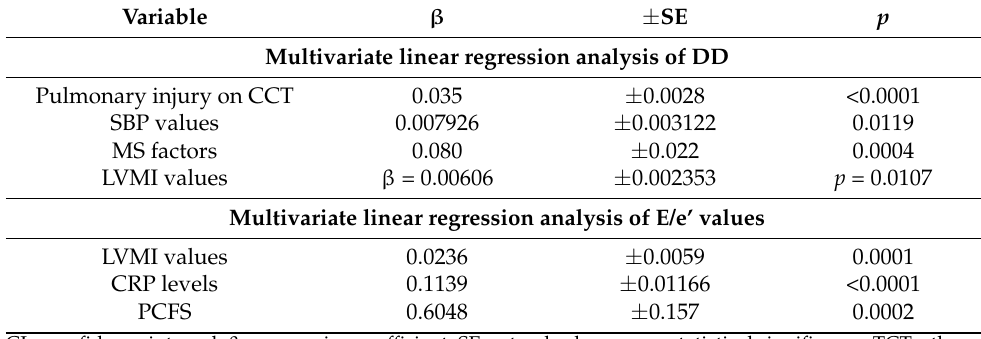
Table 5. Multivariate linear regression